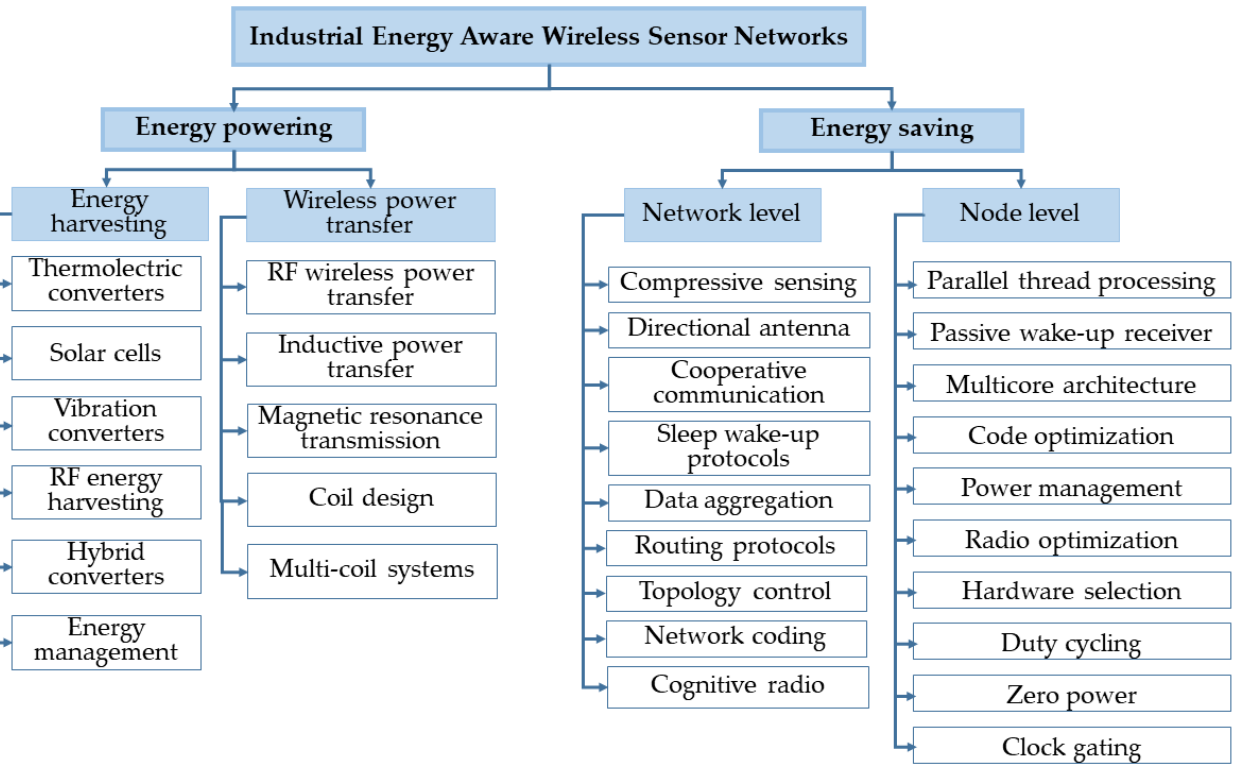
Figure 3. Taxonomy for industrial energy-aware wireless sensor networks.